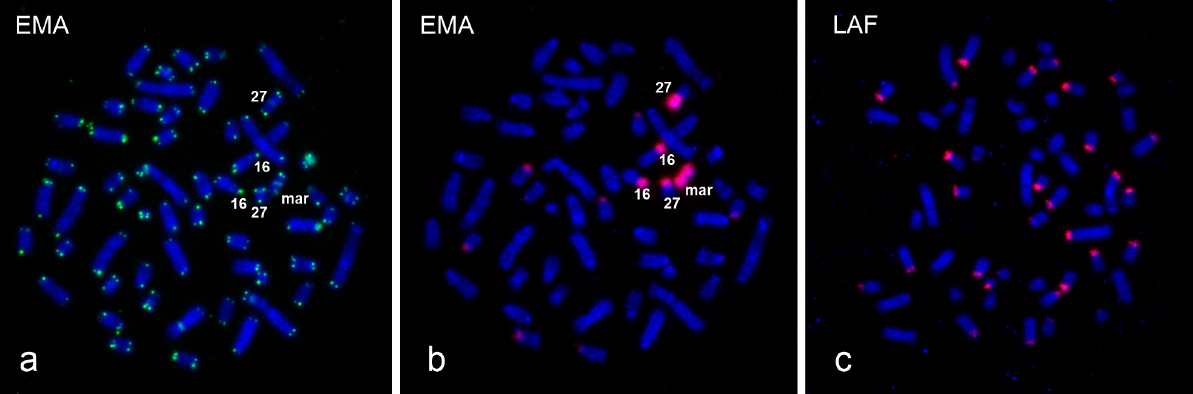
Figure 5. ( a ) FISH of a telomeric probe (green) to the E. maximus , EMA (2n = 57,XY,+mar). ( b ) The same metaphase spread hybridized with the EMAM1 probe (red). ( c ) FISH of the LAFM1 probe (red) to the L . africana , LAF chromosomes (2n = 56,XX). The chromosomes are counterstained with DAPI (blue).